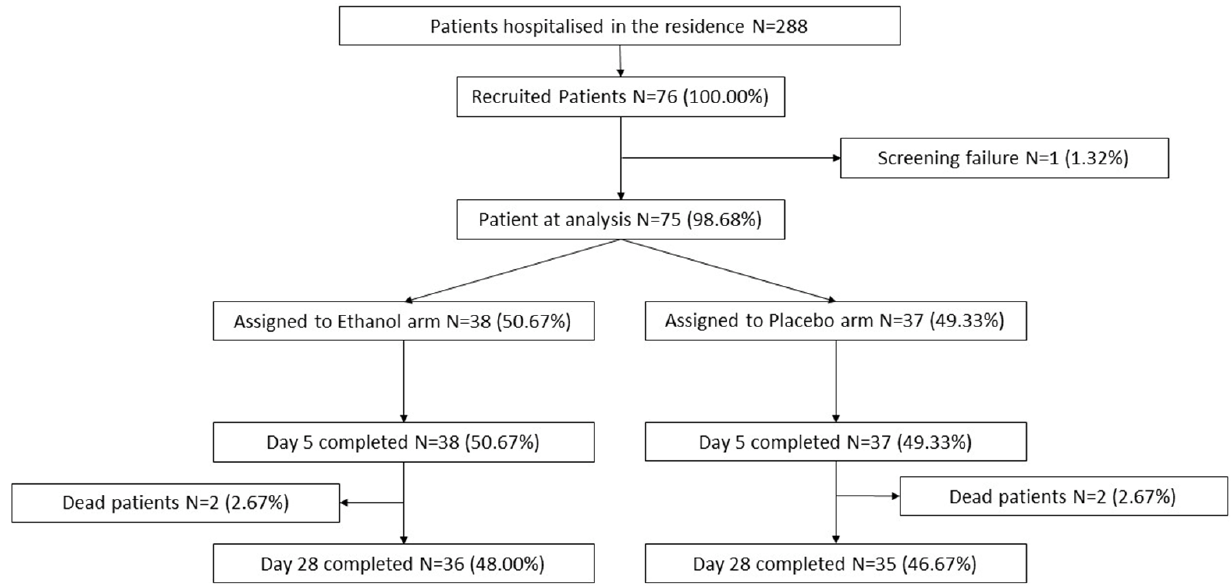
Figure 2. Trial flow chart showing patient enrollment, group allocation and deaths.